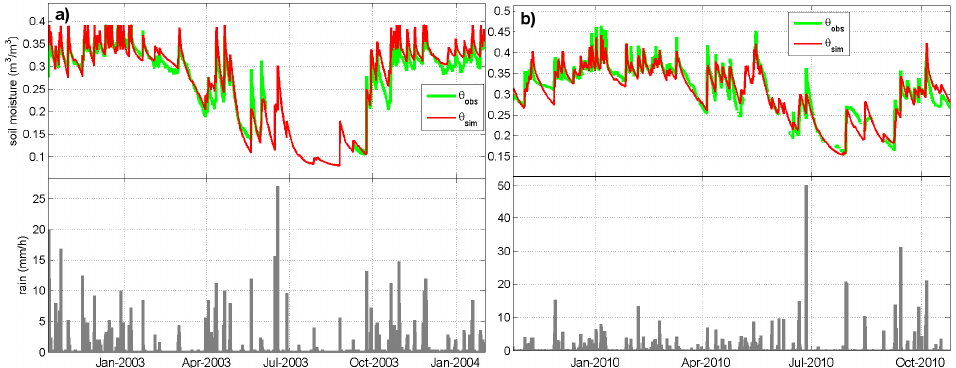
Figure 3. Modelled, θ sim , through the Soil Water Balance Model [67], versus observed, θ obs , soil moisture for: Colorso ( a ); and Ingegneria ( b ) sites in central Italy. The agreement between observed and modelled data reveals the good capability we achieved in simulating point scale soil moisture temporal evolution.